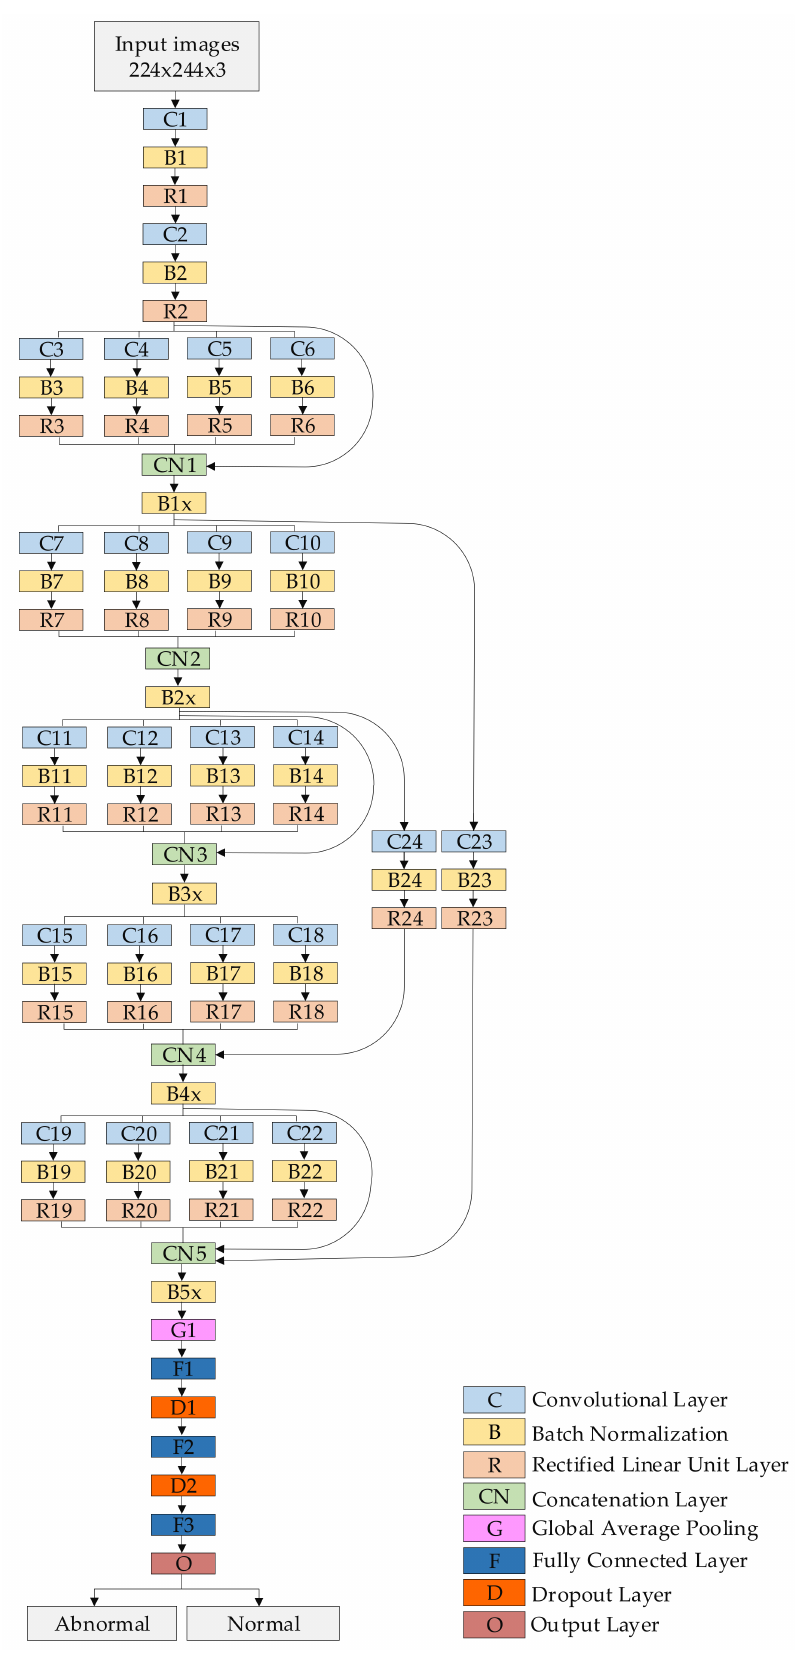
Figure 8. The proposed model